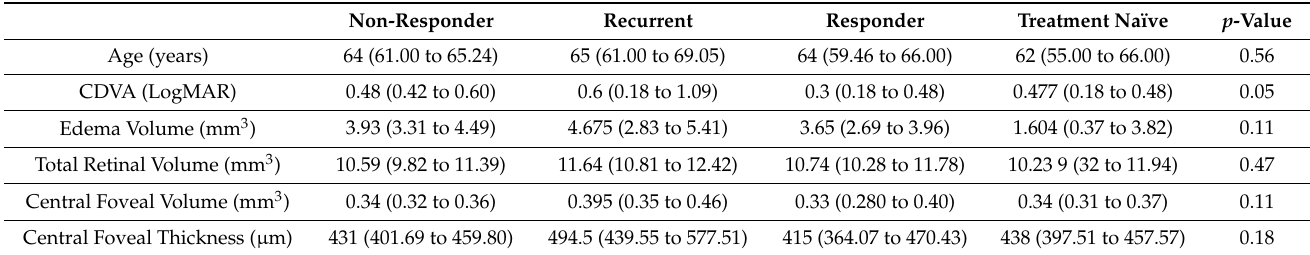
Table 2. Median with range of indices for the DR eyes based on response to treatment.